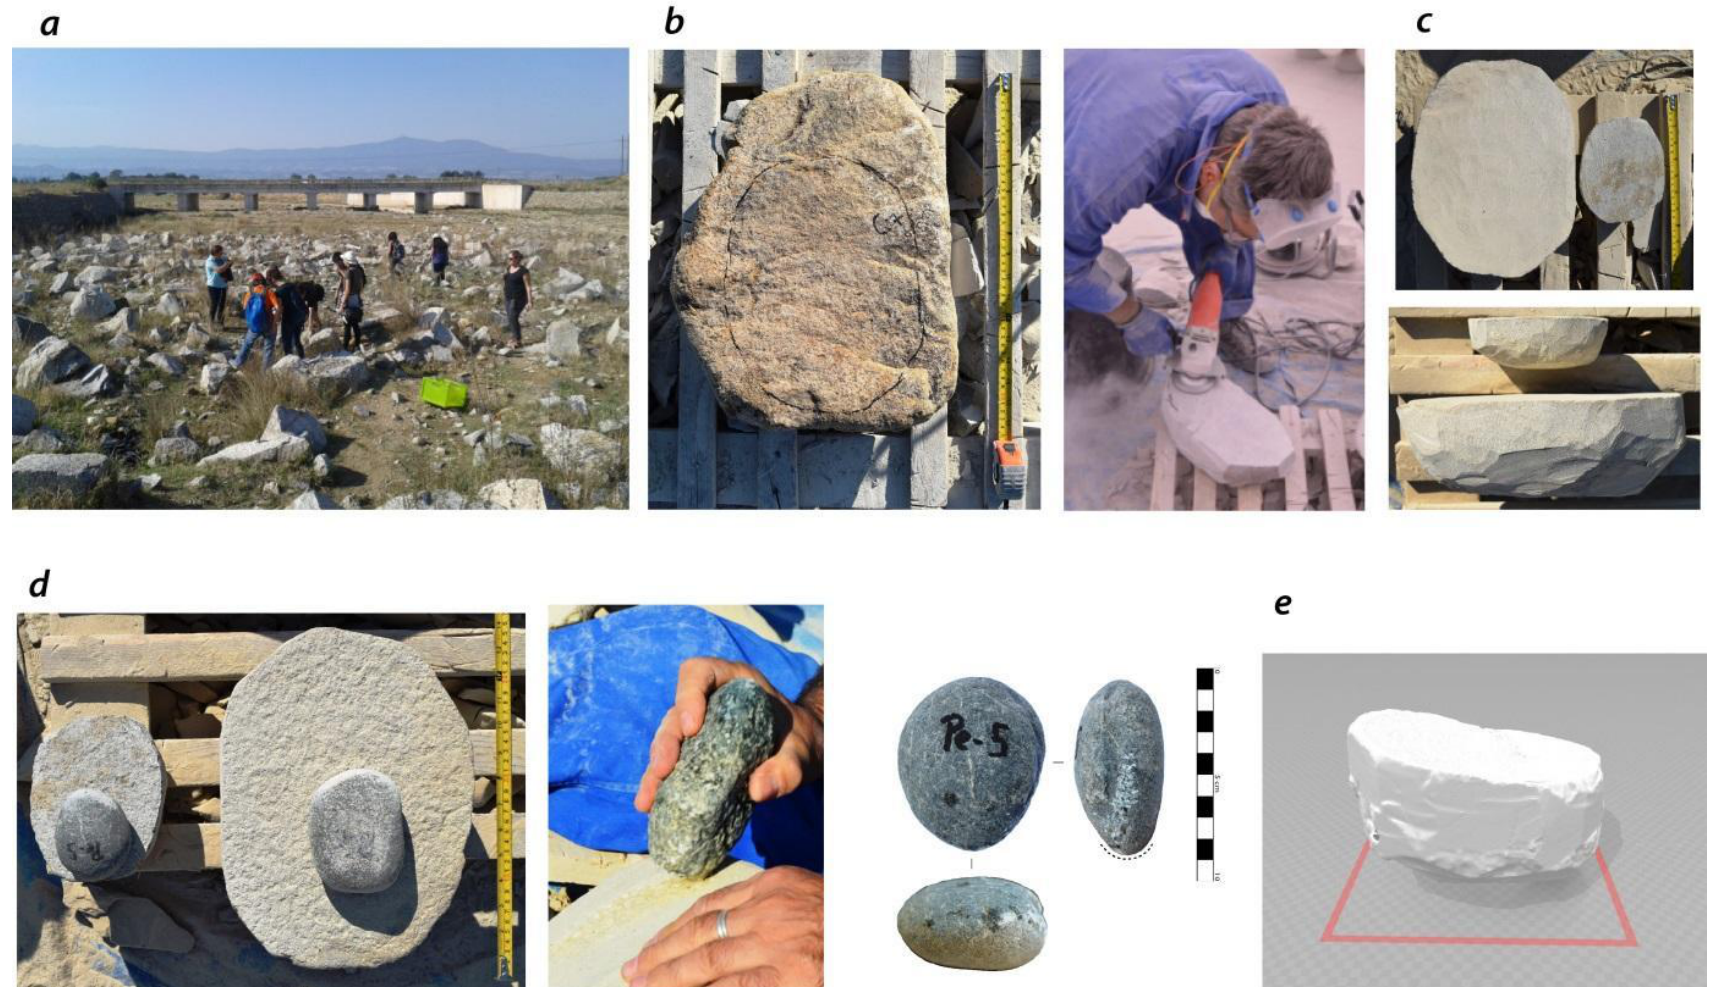
Figure 2. Raw material procurement in northern Greece area (a); manufacture process of the grinding stone tools using mechanical means to shape the boulders (b-c); and examples of hammerstones preparing the active surfaces by pecking (d). 3D scanning after the manufacture